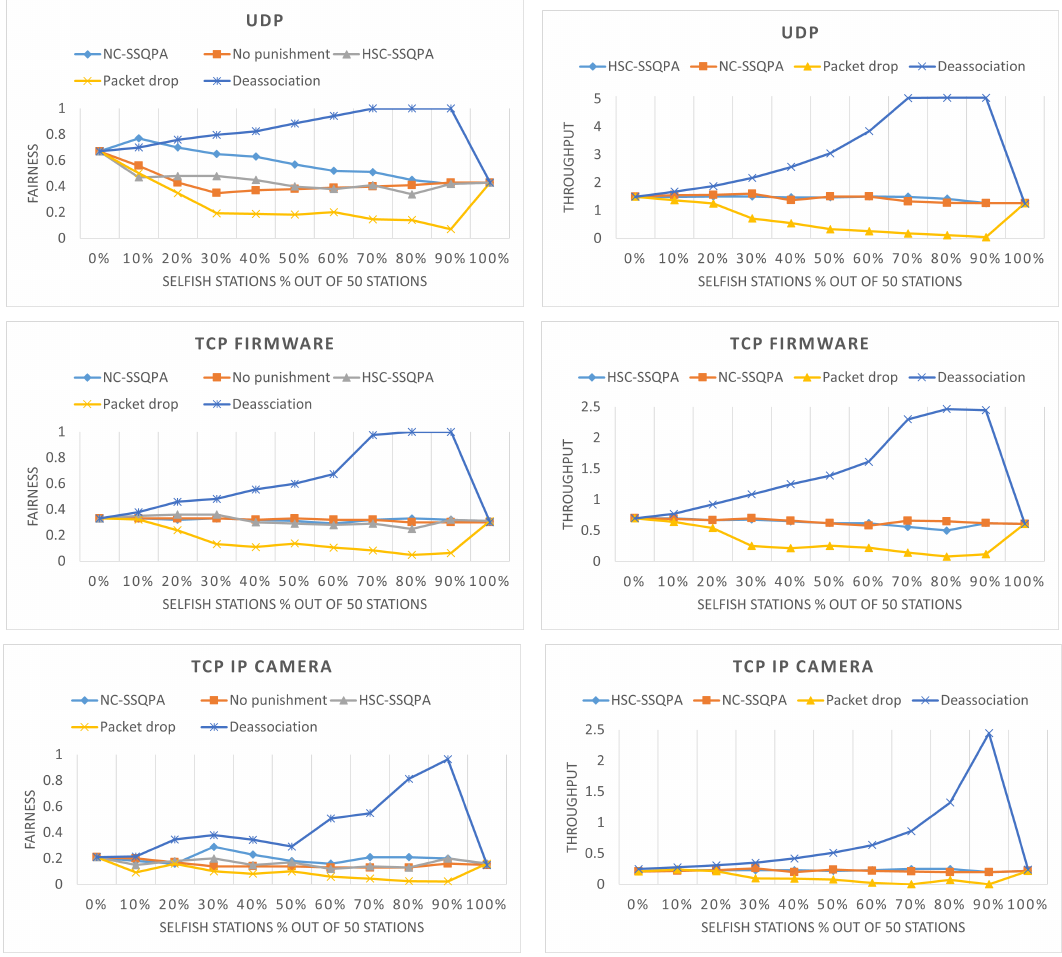
Figure 17. ( left ) Network fairness, ( right ) Network throughput (in Mbps)—for different mitiga- tion